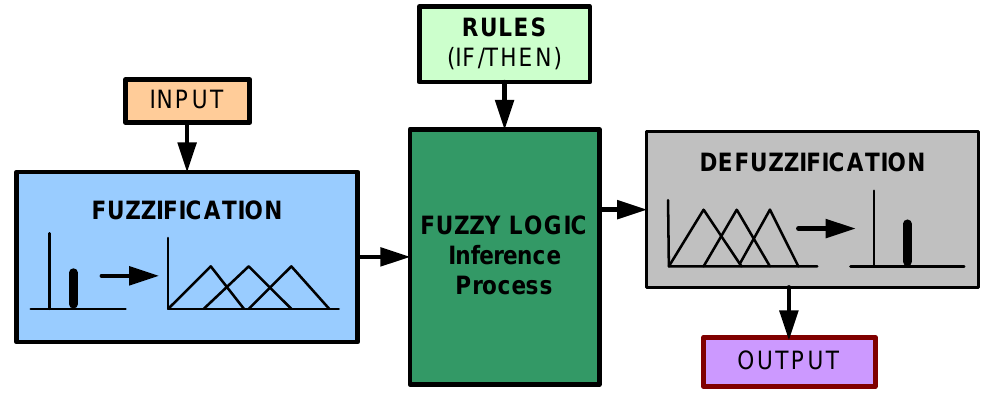
Figure 14. Framework of a rule based fuzzy system (adapted from [124]).